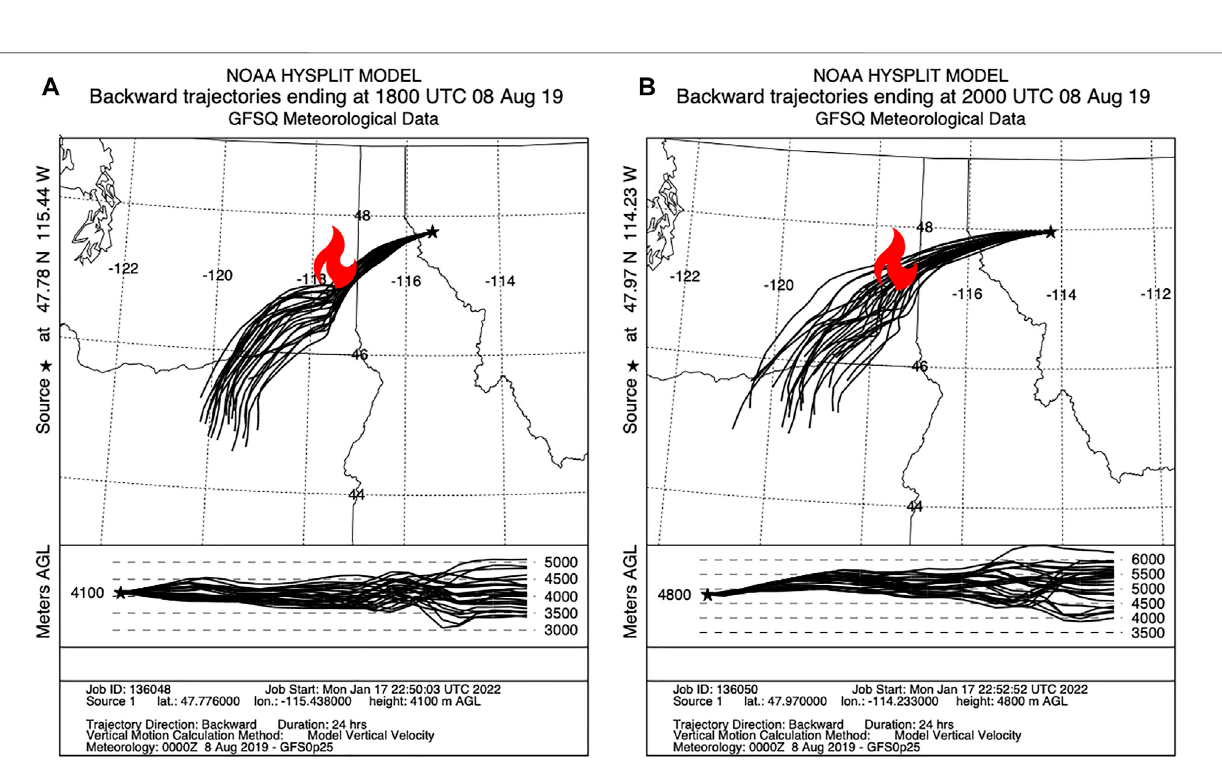
Frontiers in Remote Sensing |